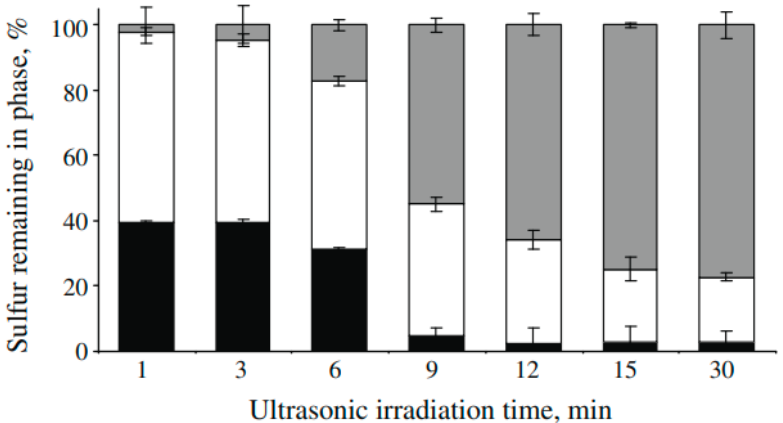
Figure 1. Sulfur distribution in the oil, solvent and aqueous phase, according to the ultrasonic irradiation time (25 mL of oil containing sulfur 211 mg, 15 mL of acetic acid, and 10 mL of 50% ( v/v ) H 2 O 2 solution, ultrasound 20 kHz, set at 40%, extraction with MeOH, n = 3) [57].